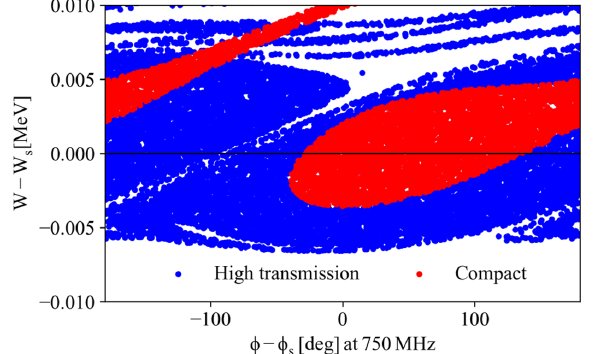
FIG. 5. Longitudinal acceptance for high transmission (blue) and compact (red) RFQ.